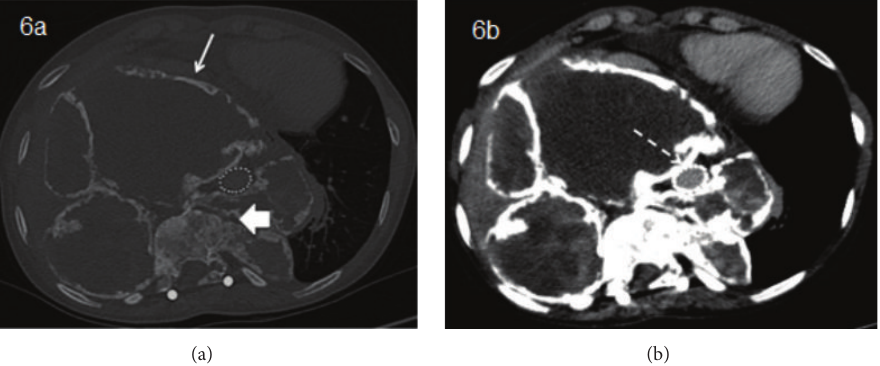
Figure 6: Long-term follow-up CT after continued treatment with denosumab showing more prominent calcification (wide arrow) and reduction of the soft tissue component (narrow arrow). The aortic stent is seen, without extravasation of contrast (dashed